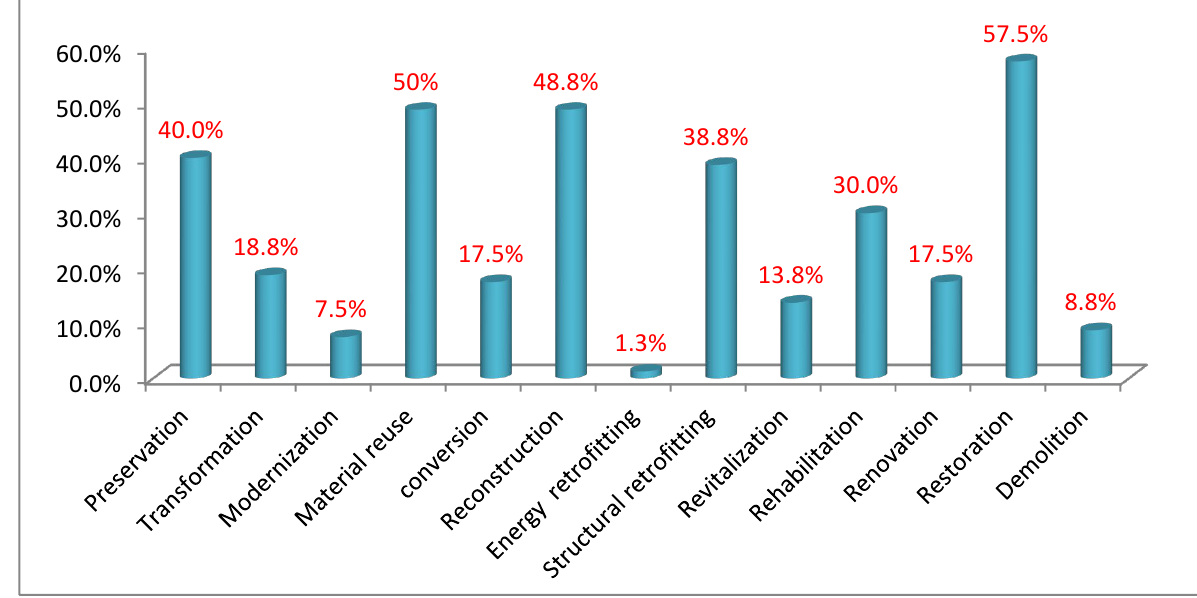
Figure 11. Percentages of adaptation projects in the Erbil Citadel and the buffer zone.